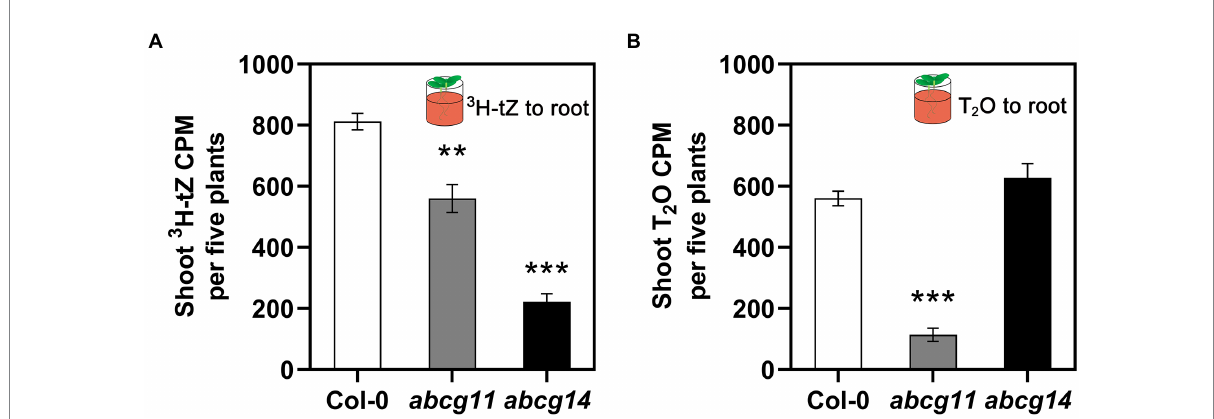
FIGURE 7 The root-to-shoot transfer of [3H]tZ and T 2 O. Only the roots of 12-day-old seedlings were treated with 50 nM 3 H-tZ or 0.5 mCi/ml T 2 O for 1 h, and then the shoots were harvested for the assay of the transferred 3 H-tZ or T 2 O. The error bars represent the standard deviation (SE; n = 6–8). The asterisks represent the significant differences between mutants and wild type by Student’s t -test: ** p < 0.01, *** p <